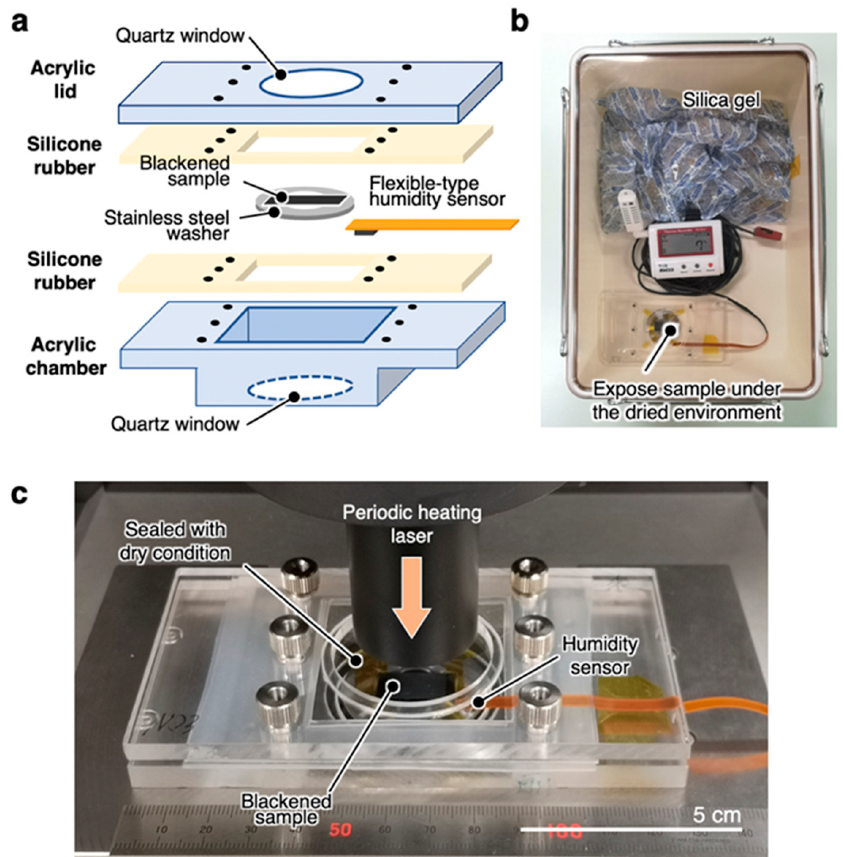
Figure 2. System for measuring the thermal diffusivity under dry conditions. ( a ) Setup of the sealing chamber. ( b ) Chamber holding the sample conditioned in the tightbox under relative humidity below 10% with an excess amount of dried silica gel. ( c ) Sealed chamber under dry conditions mounted on the TA33 stage to measure the thermal diffusivity.